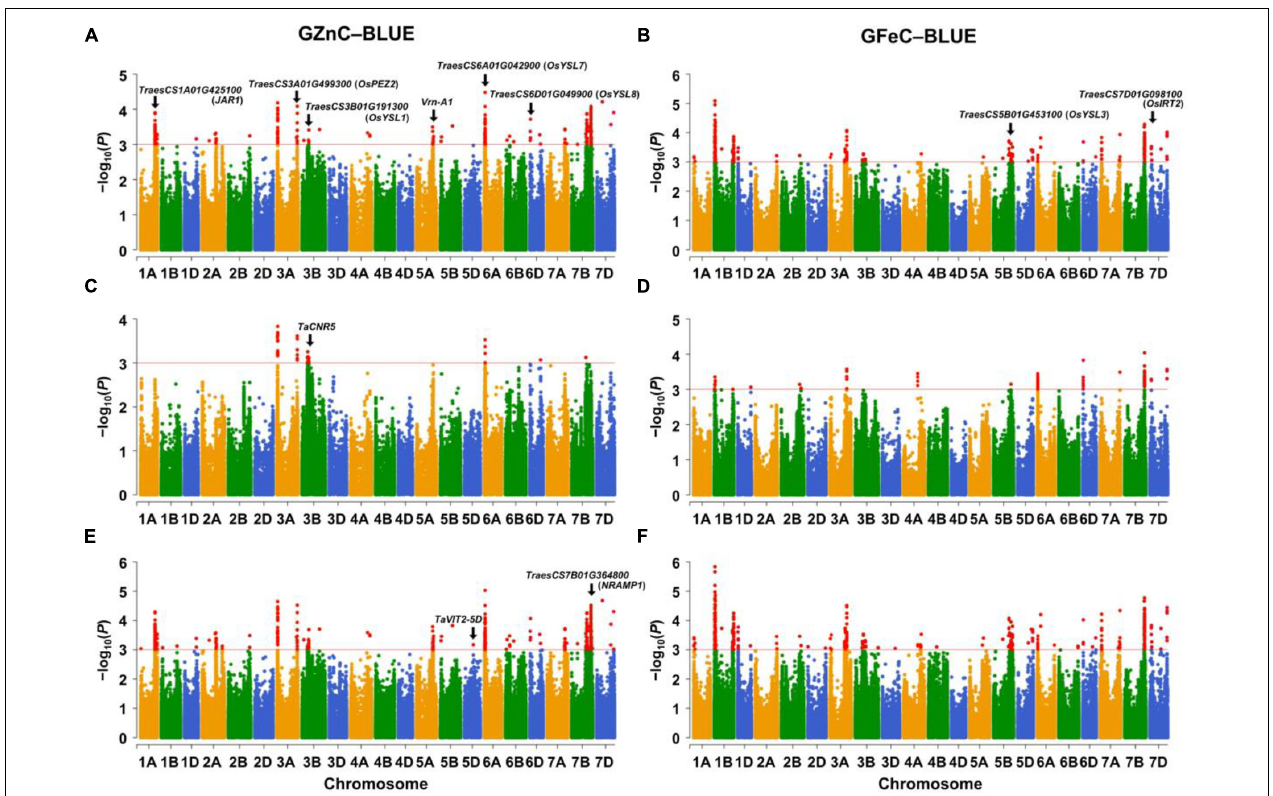
FIGURE 1 | Manhattan plots for GZnC and GFeC analyzed by (A,B) the mixed linear model (MLM), (C,D) the fixed and random model circulating probability unification (FarmCPU), and (E,F) the multiple loci mixed linear model (MLMM). The threshold of p = 1.0 × 10 − 3 (–log 10 ( p ) = 3.0) was used for calling significant marker-trait associations (MTAs). GZnC and GFeC indicate grain zinc and iron concentrations, respectively. BLUE indicates the best linear unbiased estimations across environments. The wheat gene ID indicates cloned wheat genes or wheat orthologs of known Zn/Fe-related genes in model